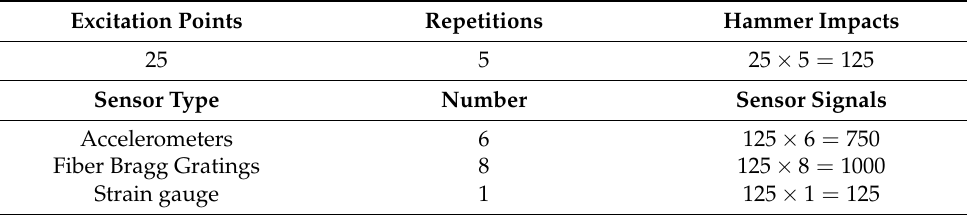
Table 2. Summary of post-processed